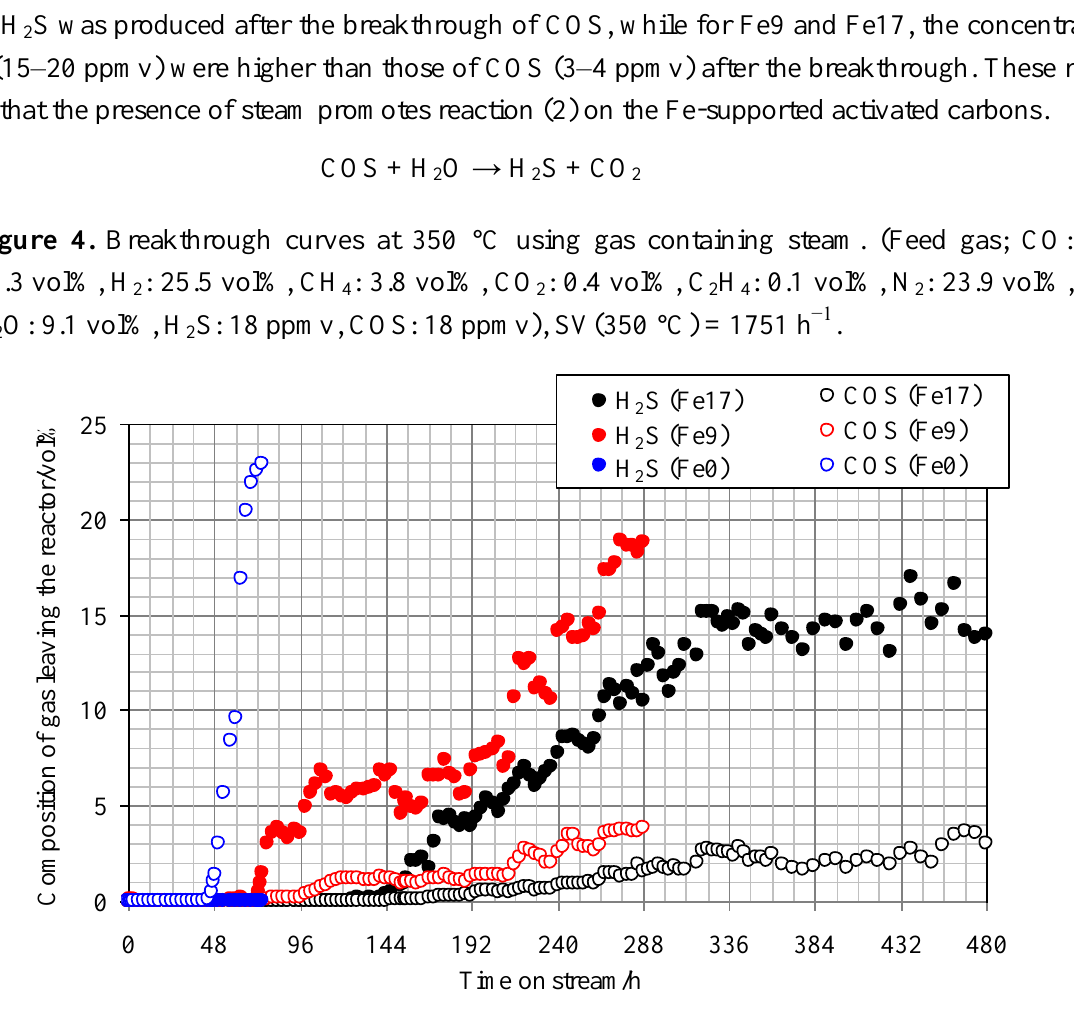
H : 0.1 vol%, N 2 4